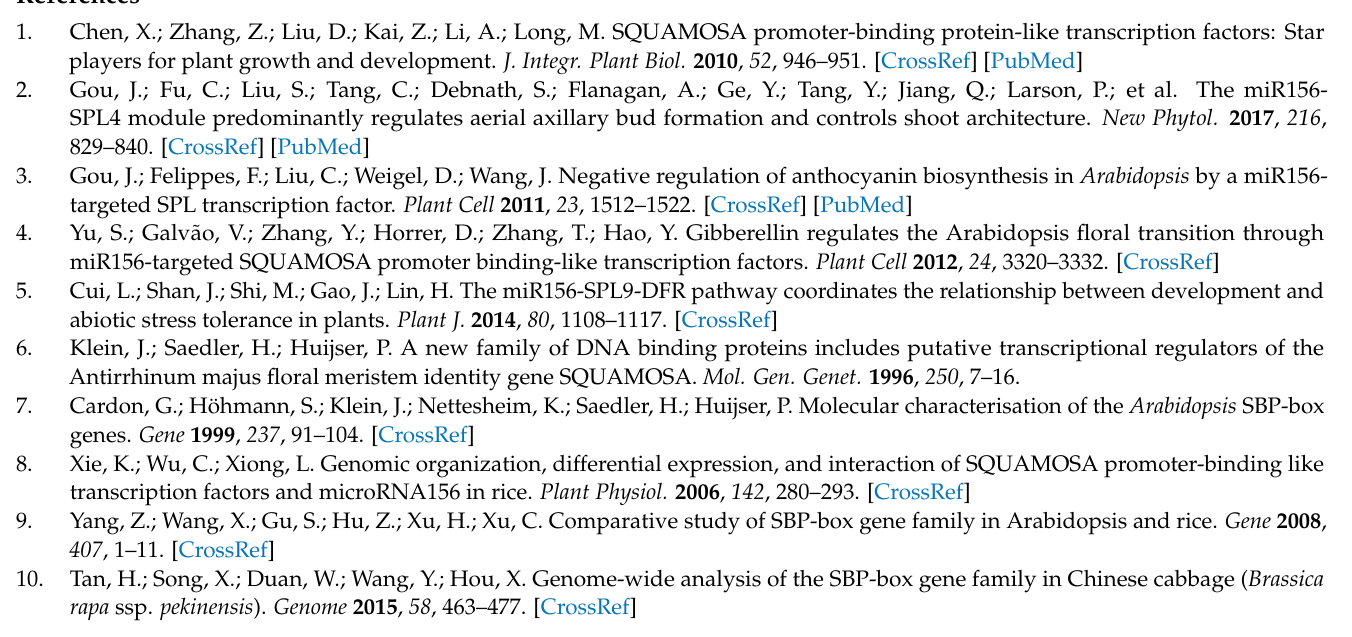
Table S2. The coding sequences of the 33 SPL genes of B. oleracea ; Table S3. Amino acid sequences